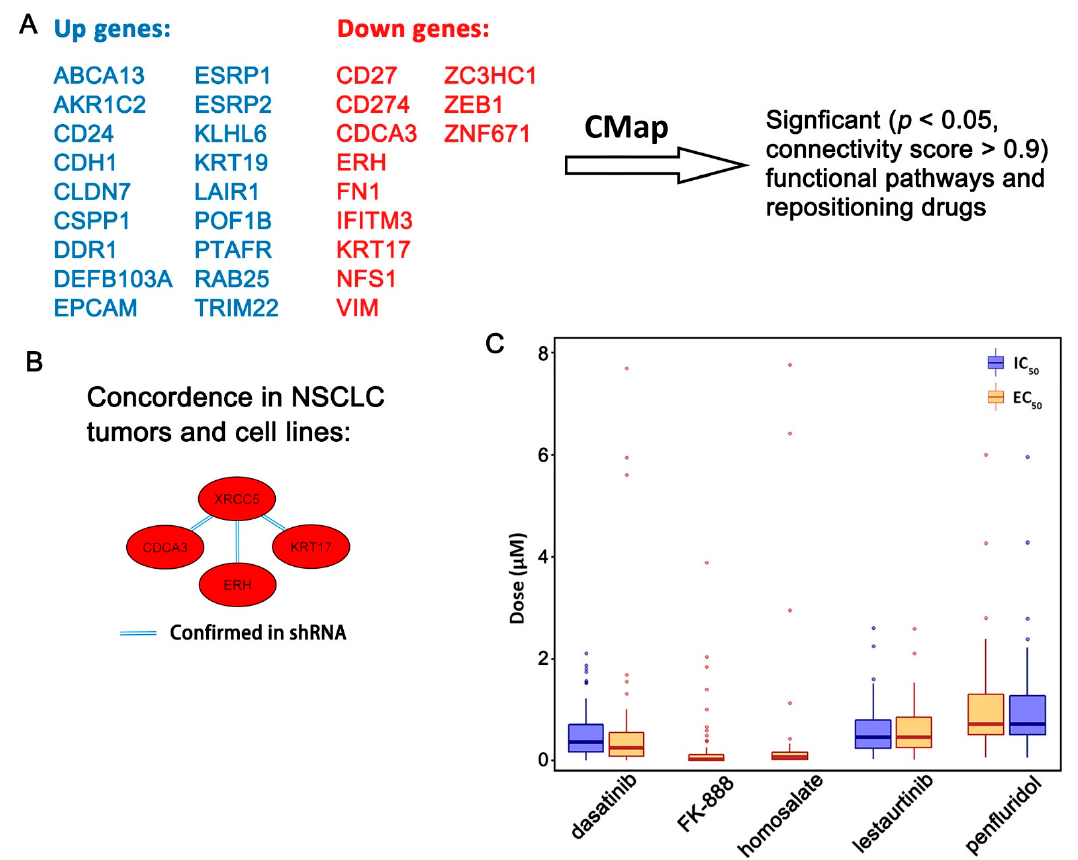
Figure 6. Identification of functional pathways associated with the 7-gene multi-omics network and discovery of reposi- tioning drugs. ( A ) Selection of significant functional pathways and repositioning drugs based on the identified 7-gene multi-omics proliferation network with CMap. ( B ) Confirmed co-expression network of XRCC5 in NSCLC patient tumors in GSE31800 or GSE28582 showing concordant co-expression patterns after shRNA knock-down of XRCC5 in A549 cell line. The red color indicates down-regulation or non-upregulation of genes. The double line indicates that the co-expres- sion relations ( p < 0.05, z -tests) observed in patient tumors were confirmed in shRNA knockdown experiments in LINCS L1000 CMap NSCLC cell lines. ( C ) Small molecules that had a low average concentration of drug response in the CCLE NSCLC cell lines. Measurements with a drug activity value larger than 10 μ M were considered outliers and were removed from the plot. Dasatinib EC 50 measurements had 2.38% of outliers. FK-888 EC 50 measurements had 14.49% of outliers. Homosalate EC 50 measurements had 7.25% of outliers. Penfluridol had 1.25% of outliers in both IC 50 and EC 50 measure- ments. Detailed information was provided in Supplementary File